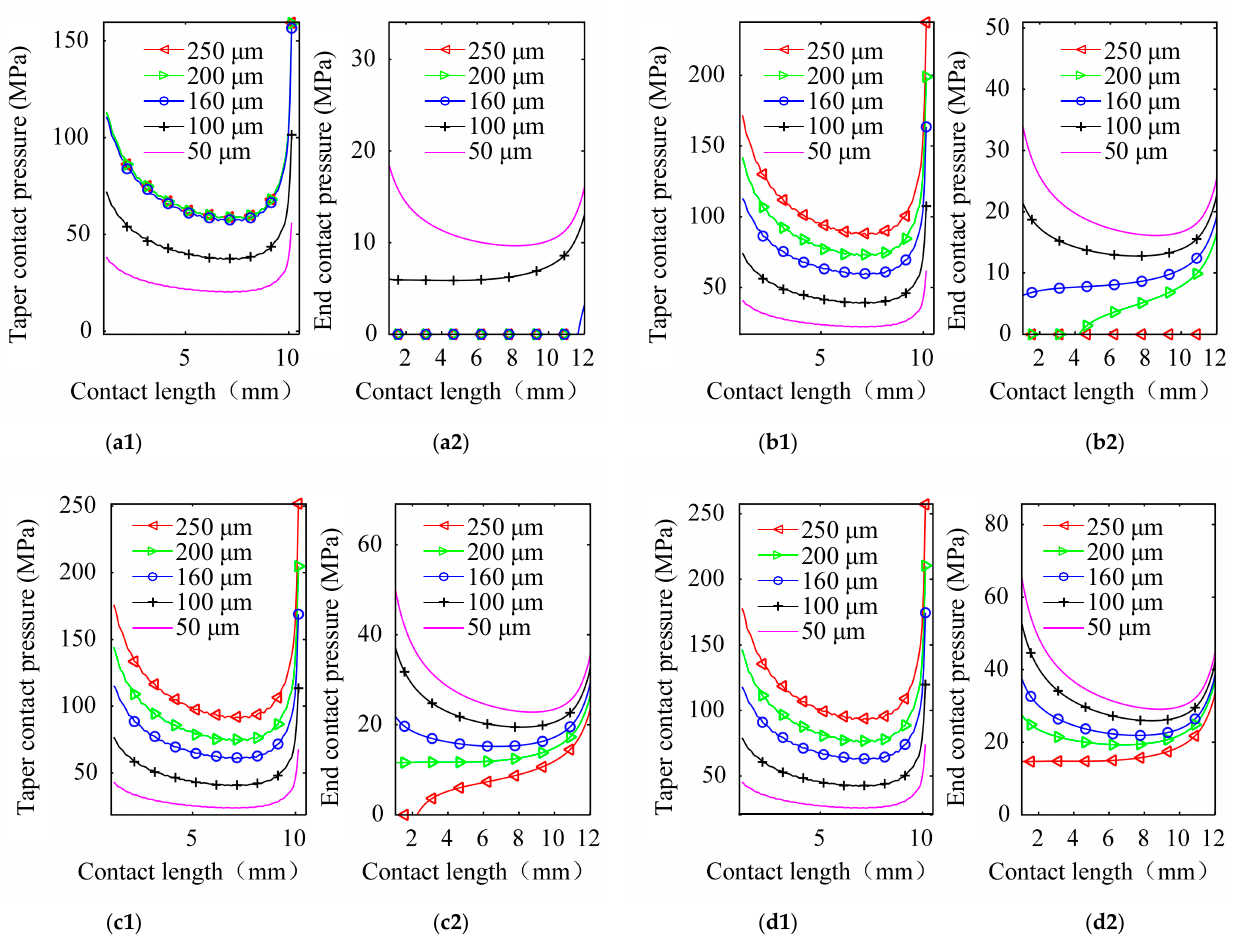
Figure 9. Effect of end clearance on contact pressure of the spindle–GWF interface under different tightening torques: ( a1 , a2 ) tapered contact pressure and end contact pressure of interface when tightening torque is 20 N·m; ( b1 , b2 ) tapered contact pressure and end contact pressure of interface when tightening torque is 30 N·m; ( c1 , c2 ) tapered contact pressure and end contact pressure of interface when tightening torque is 40 N·m; ( d1 , d2 ) tapered contact pressure and end contact pressure of interface when tightening torque is 50 N·m.